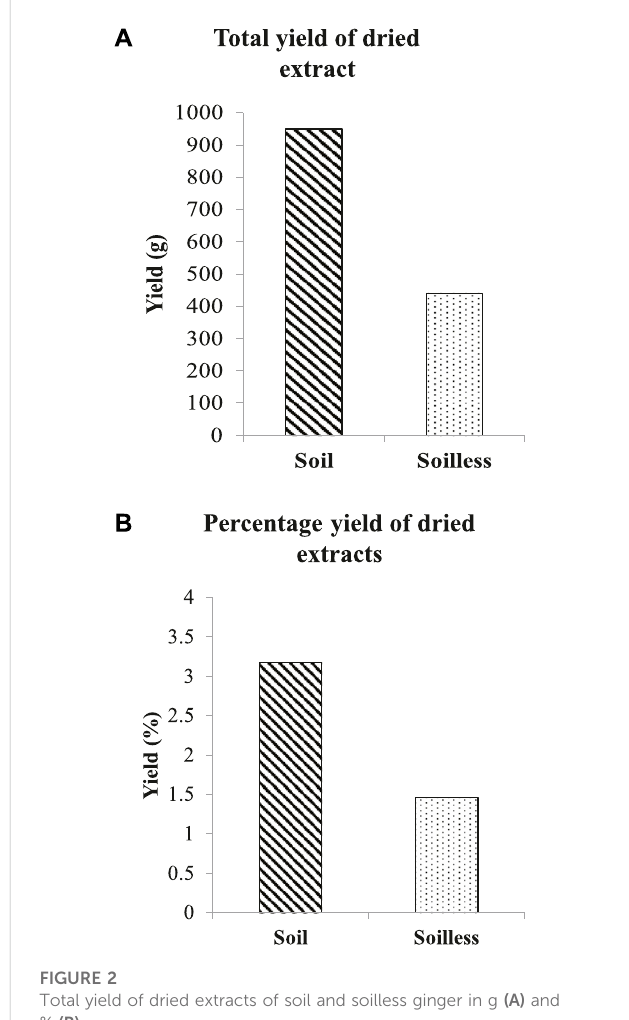
FIGURE 2 Total yield of dried extracts of soil and soilless ginger in g (A) and % (B)